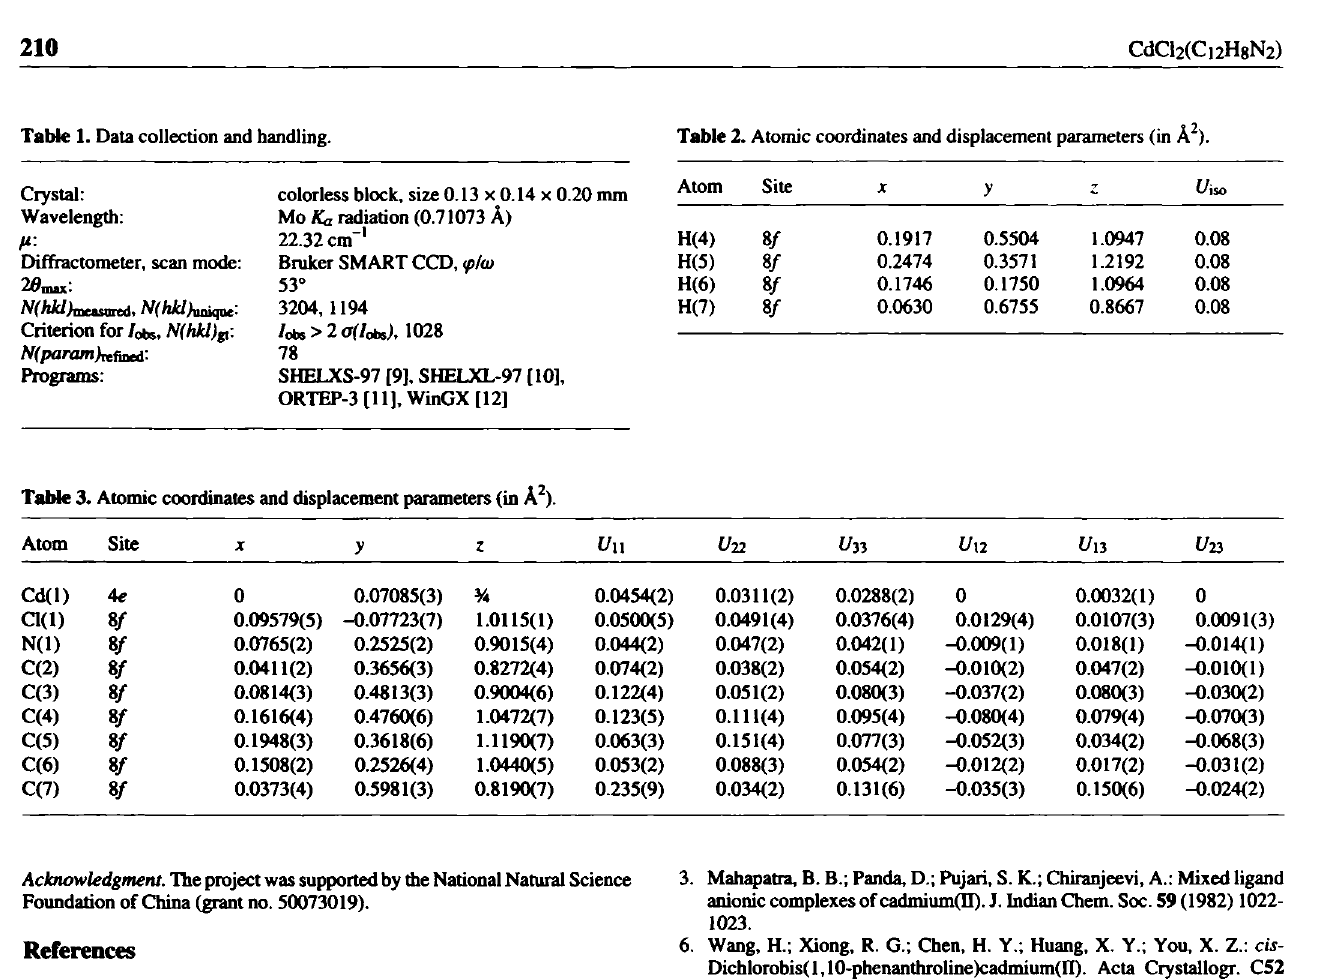
Table 3. Atomic coordinates and displacement parameters (in A 2